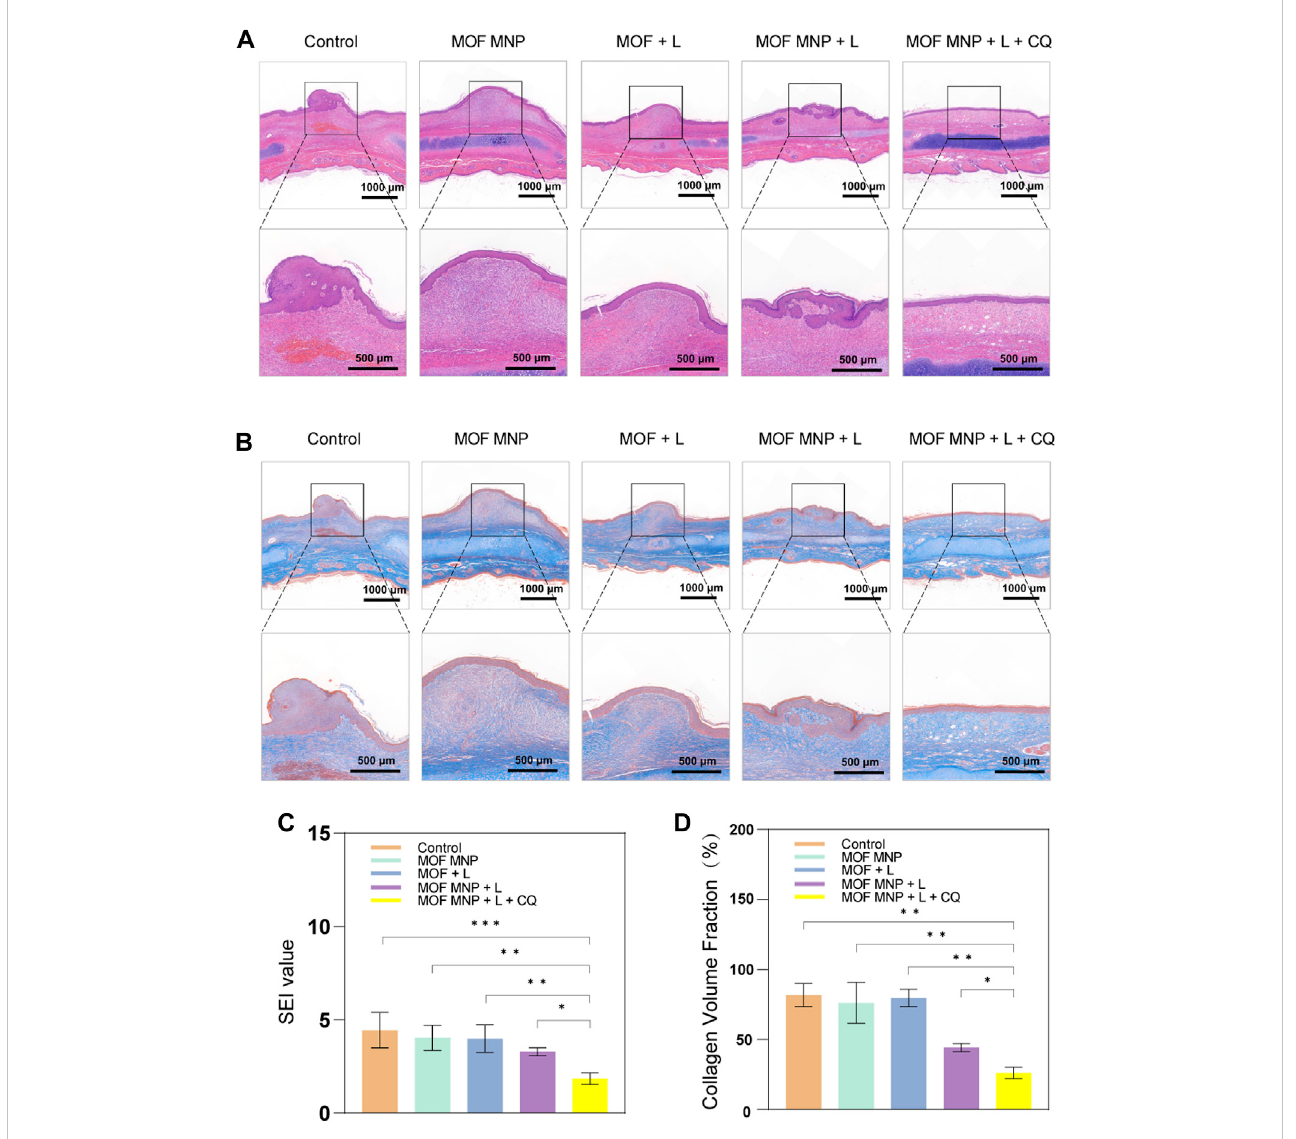
FIGURE 5 Histological analysis of HSs with different treatments. (A) Representative H&E staining images of rabbit HSs after different treatments. (B) Masson ’ s staining images of rabbit HSs after different treatments. (C) SEI and (D) CVF of HSs after different treatments. ( n = 4, * P < 0.05; ** P < 0.01; *** P < 0.001).